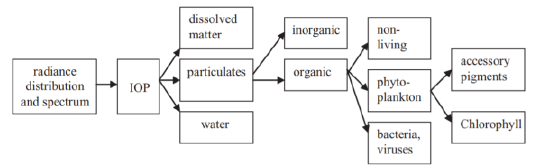
Figure 2. Diagram of inverse radiative transfer elements from Ocean Color Algorithms Working Group Report 5 (IOCCG, 2006) Inversion of these known relationships